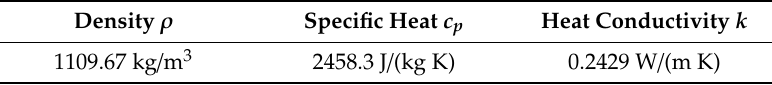
Table 3. Thermophysical properties of the base fluid (EG).